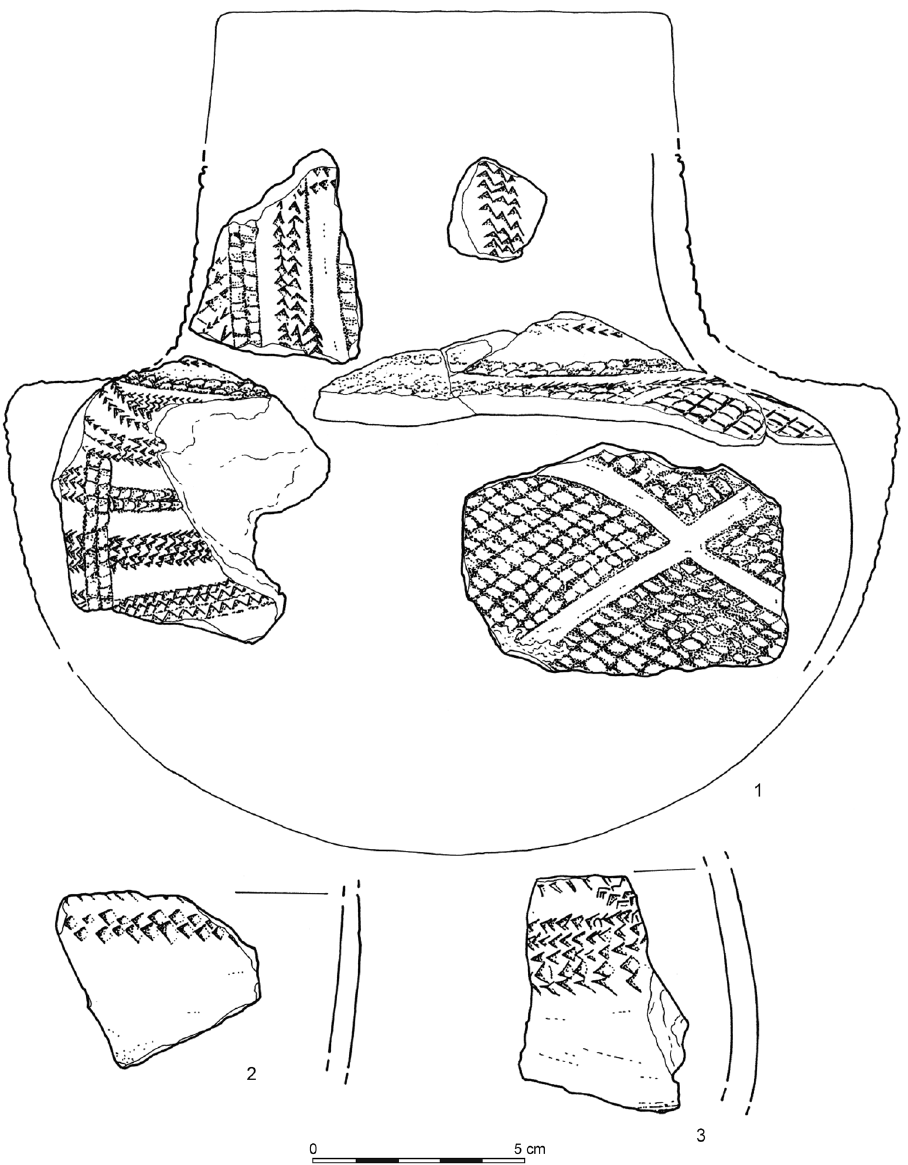
Figure 4: Pottery recorded at D ą bki ( 1 – 3 ) ( after Czekaj - Zastawny, 2015 ) , attributed to the Bodrogkeresztúr culture by its discoverers ( Czekaj - Zastawny, 2015; Czekaj - Zastawny, Kabaci ń ski, & Terberger, 2011a, 2011b; Czekaj - Zastawny, Kabaci ń ski, Terberger, & Ilkiewicz, 2013 ) . Such attribution has been contested by some researchers, who claim the possible Rössen connections ( Chmielewski, 2020; Czerniak, 2018 ) ; this criticism is not shared by the present author. One way or another, this pottery certi fi es contacts between the Late Mesolithic and Neolithic